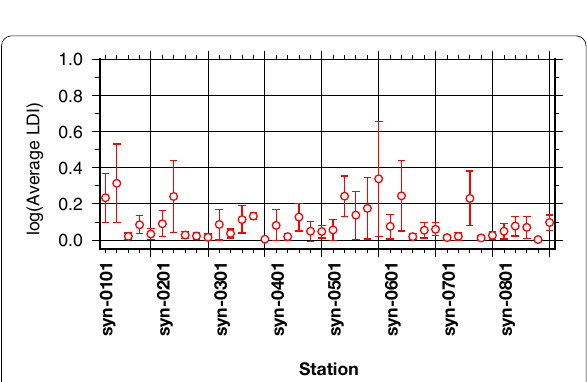
Fig. 21 Average LDIs from the synthetic model with the distorters shown in Fig.